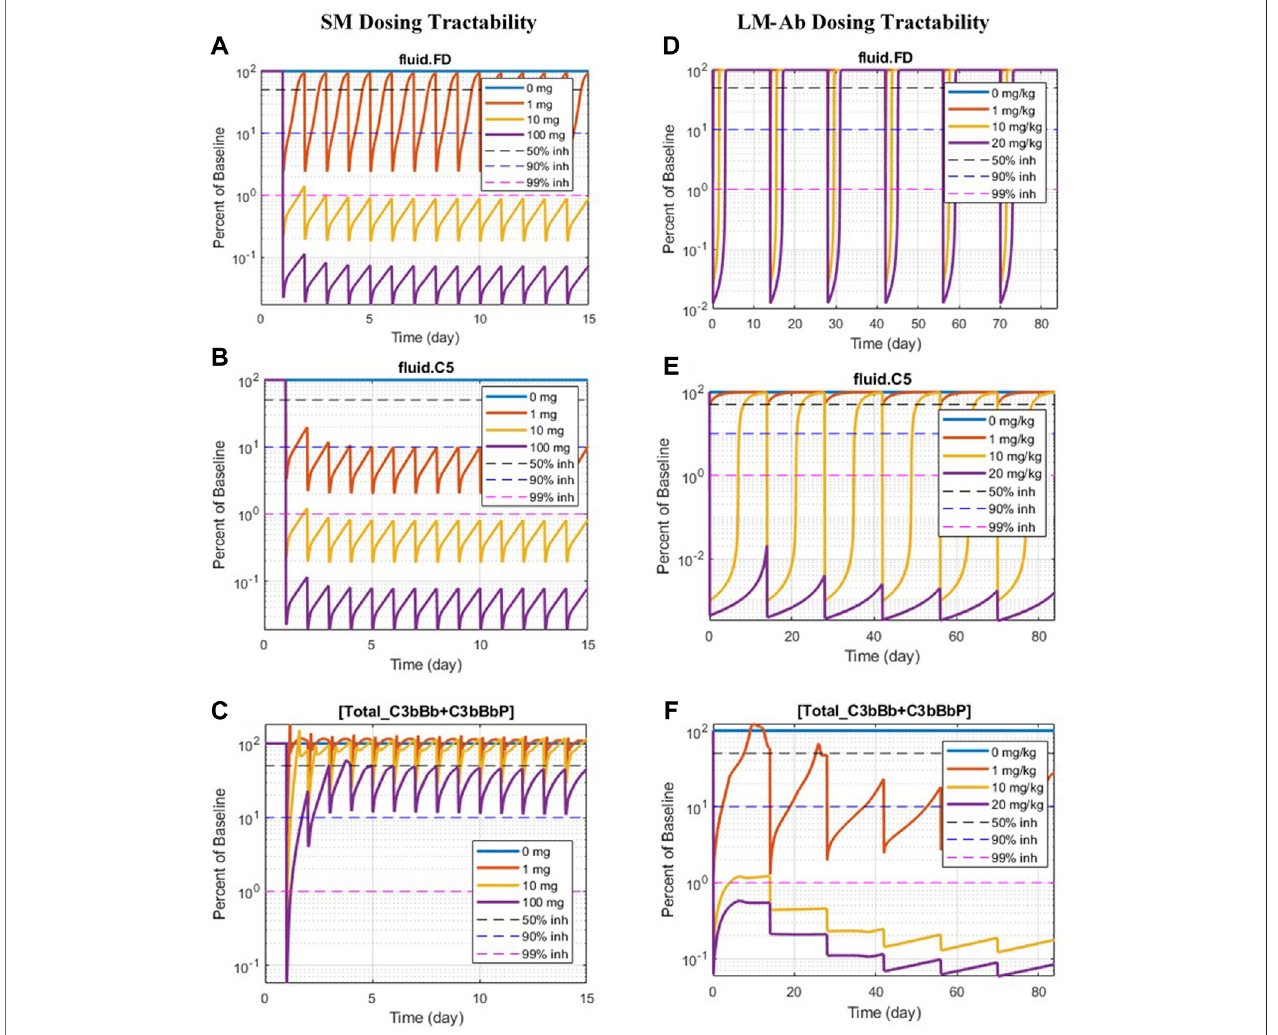
FIGURE11| DosesofSM/LM-Ab compounds neededforengagingcomplementproteins. Free complementprotein levelsareshown fordifferentdosesofSM(0, 1,10,and100 mg)andLM-Ab(0,1,10,and20 mg/kg).Dashedlines:50%inhibition(black),90%inhibition(blue),99%inhibition(pink)frombaseline.Solidlines:%free target from the baseline at different dose levels. (A , D) Blocking of FD; (B , C) blocking of C5; (C , F) blocking of C3-convertases (C3bBb +